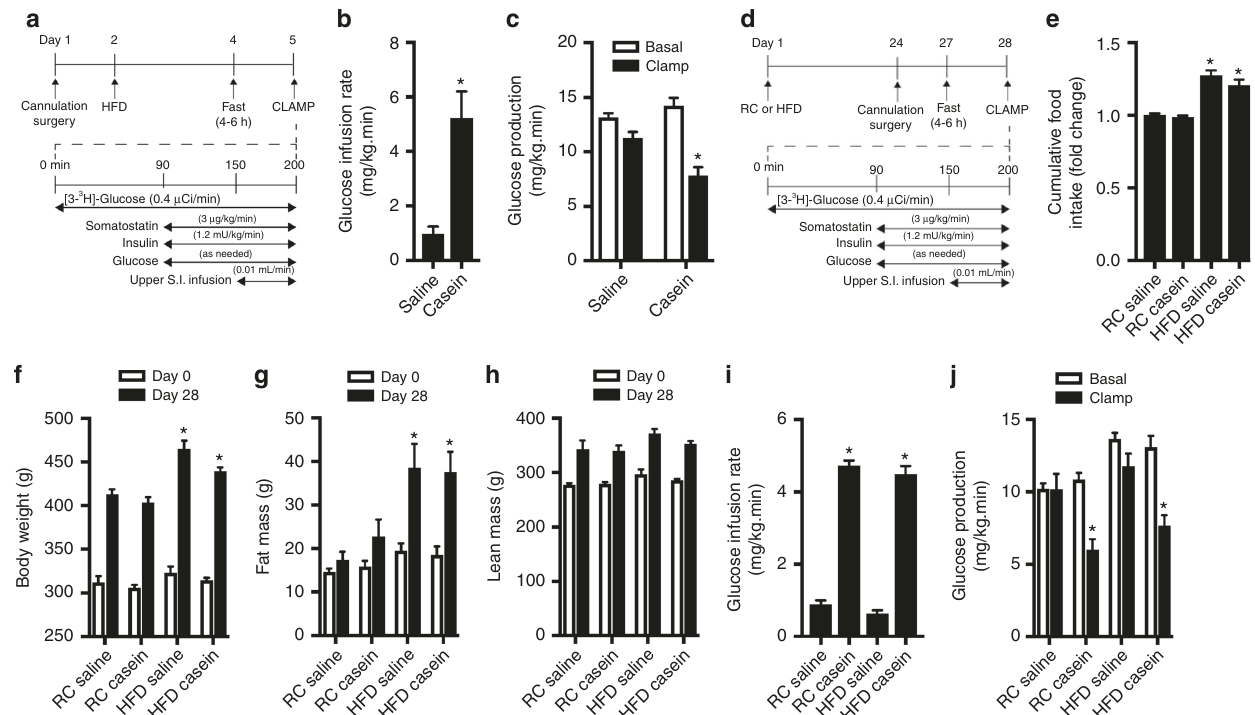
Fig. 5 Upper small intestinal infusion of casein lowers glucose production in models of early-onset insulin resistance and obesity. Rats were fed a 3-day high-fat diet (HFD) and a pancreatic (basal insulin) euglycemic clamp was performed in rats as outlined in a . Rates of glucose infusion ( b ) and glucose production (GP, c ) were determined in HFD rats that received an upper small intestinal (S.I.) infusion of saline ( n = 7) or casein ( n = 6). Rats were fed a regular chow (RC) or HFD for 28 days and a pancreatic (basal insulin) euglycemic clamp performed as outlined in ( d ). Cumulative food intake was monitored over the 28-day protocol ( e ). Body weight ( f ), fat mass ( g ), and lean mass ( h ) were measured at baseline (day 0) and at the end of the 28-day period. Rates of glucose infusion ( i ) and glucose production ( j ) were assessed following an upper S.I. infusion of saline ( n = 5 – 6) or casein ( n = 5 – 8). Values are presented as mean ± s.e.m., where basal and clamp represent the average GP of t = 60 – 90 or t = 190 – 200, respectively, and asterisk (*) represents p < 0.05 compared to respective saline control ( b , c , i , j ) or regular chow-fed rats ( e – g ). Statistical signi fi cance was determined using an unpaired, two-tailed t -test (two groups) or ANOVA with Tukey post-hoc test (3 +